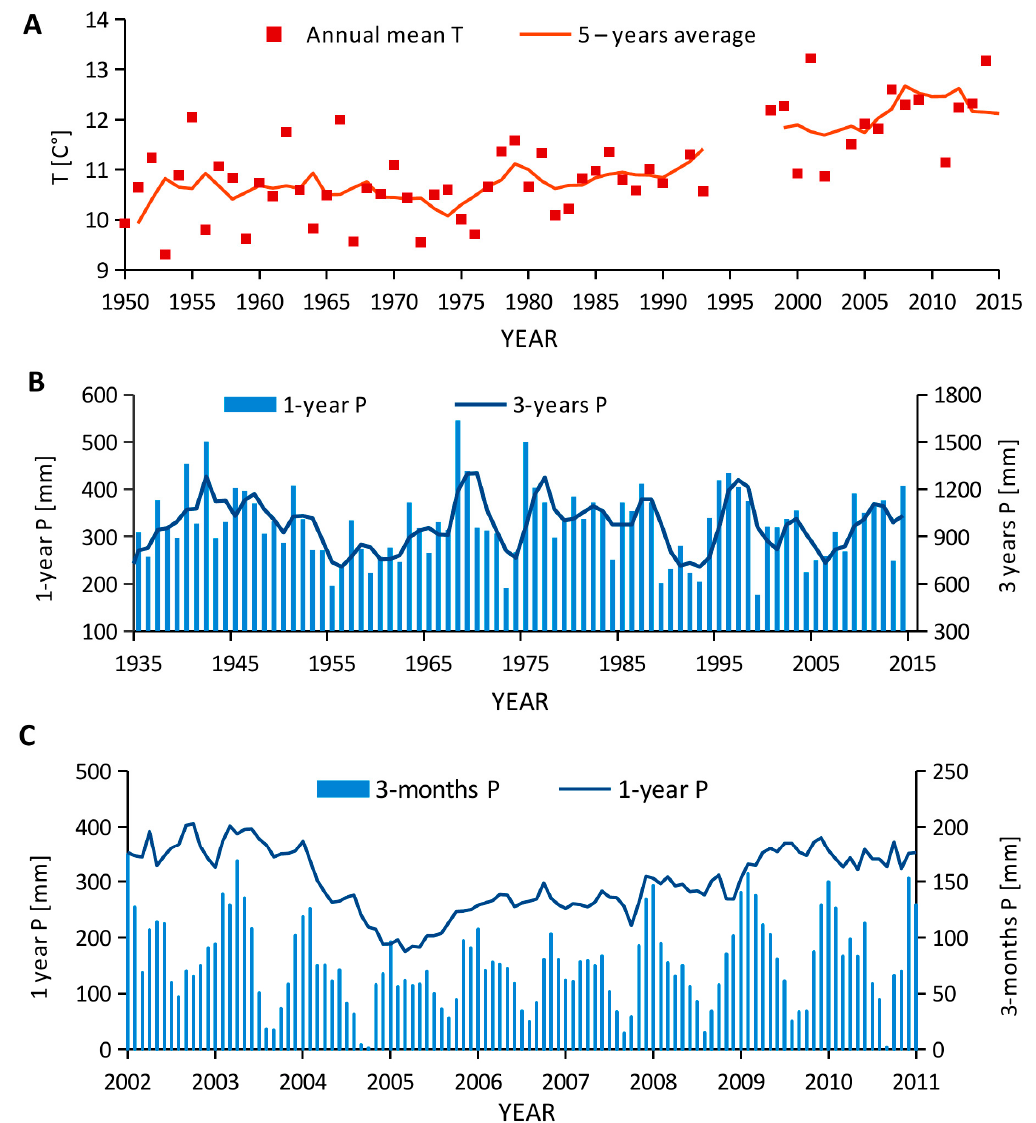
Figure 8. ( A ) Average annual and 5-year temperature for Konya station; ( B ) 1- and 3-year cumulative precipitation for Konya rain gauge; ( C ) 3-month and 1-year cumulative precipitation obtained by averaging data recorded by the five stations located in the Konya plain (Table 4).